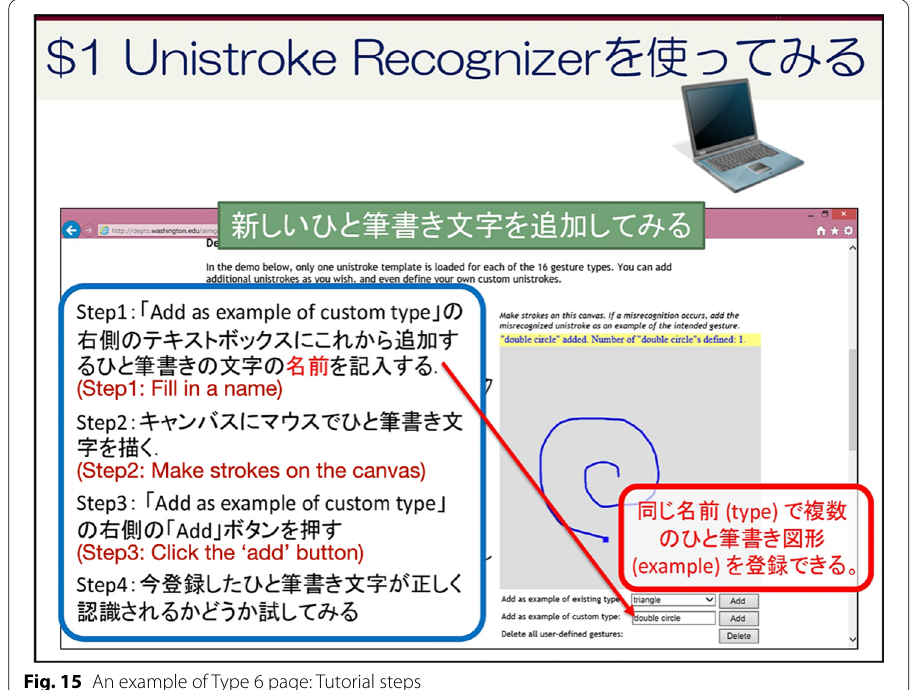
Fig. 15 An example of Type 6 page: Tutorial steps